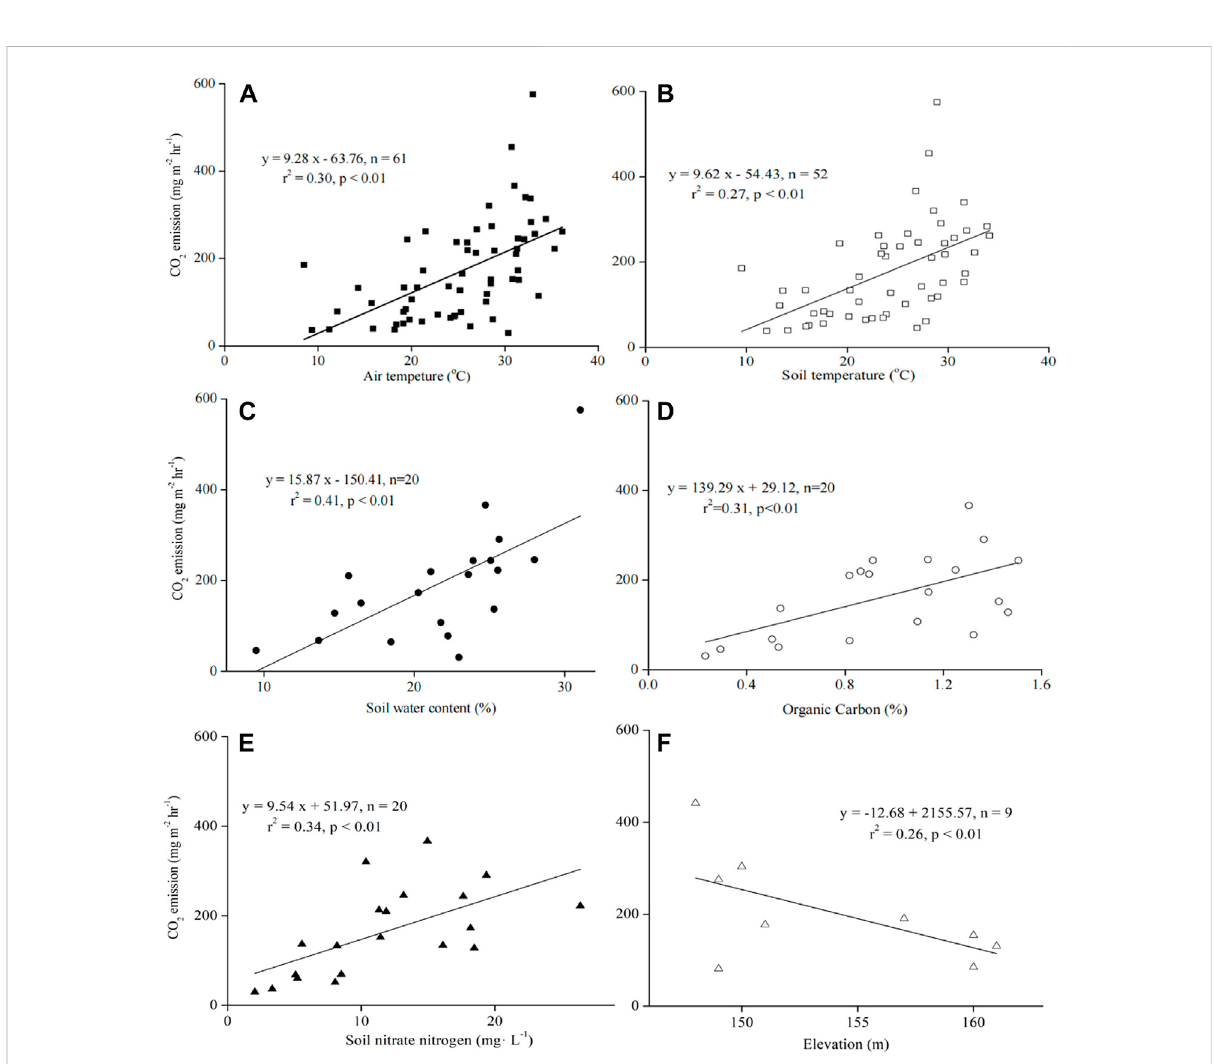
FIGURE 3 CorrelatedrelationshipsbetweenCO 2 fl uxand (A) airtemperature, (B) soiltemperature, (C) soilwatercontent, (D) organiccarbon, (E) soilnitrate nitrogen, and (F)